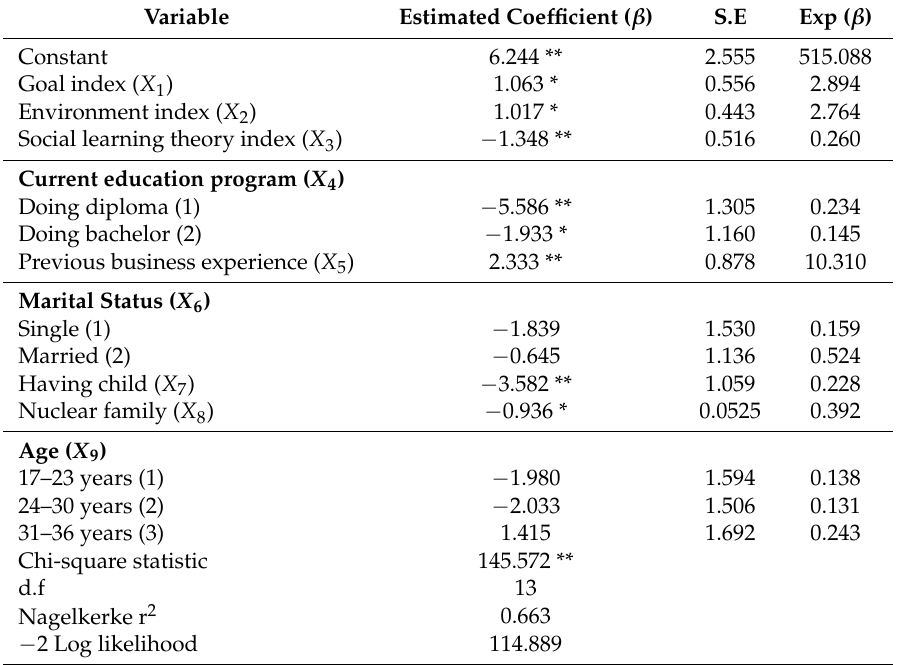
Table 7. Regression on entrepreneurial